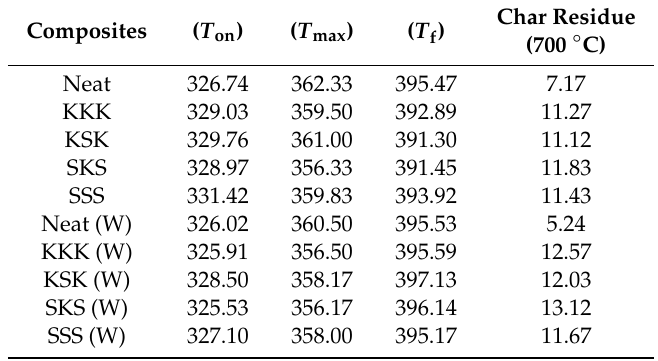
Figure 5. Thermogravimetric analysis (TGA) curves of ( a ) before and ( b ) after weathering composite samples. Differential thermogravimetry (DTG) curves of ( c ) before and ( d ) after weathering composite samples. Table 2. T on , T max , and T f of before and after weathering composite samples.